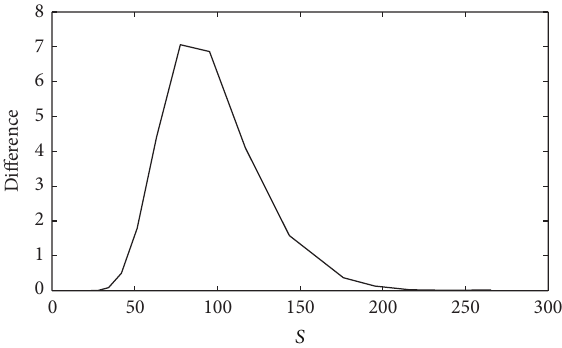
Figure 5: Difference between Black-Scholes model and Risk Adjusted Pricing Methodology.